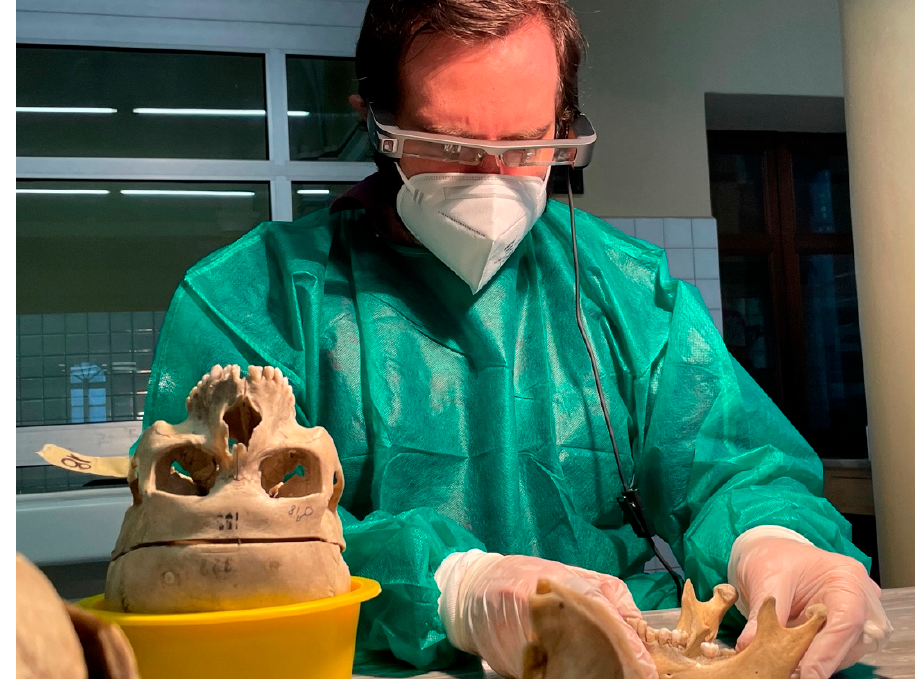
Figure 2. Operator using smart glasses to observe and record dental features on the mandible.